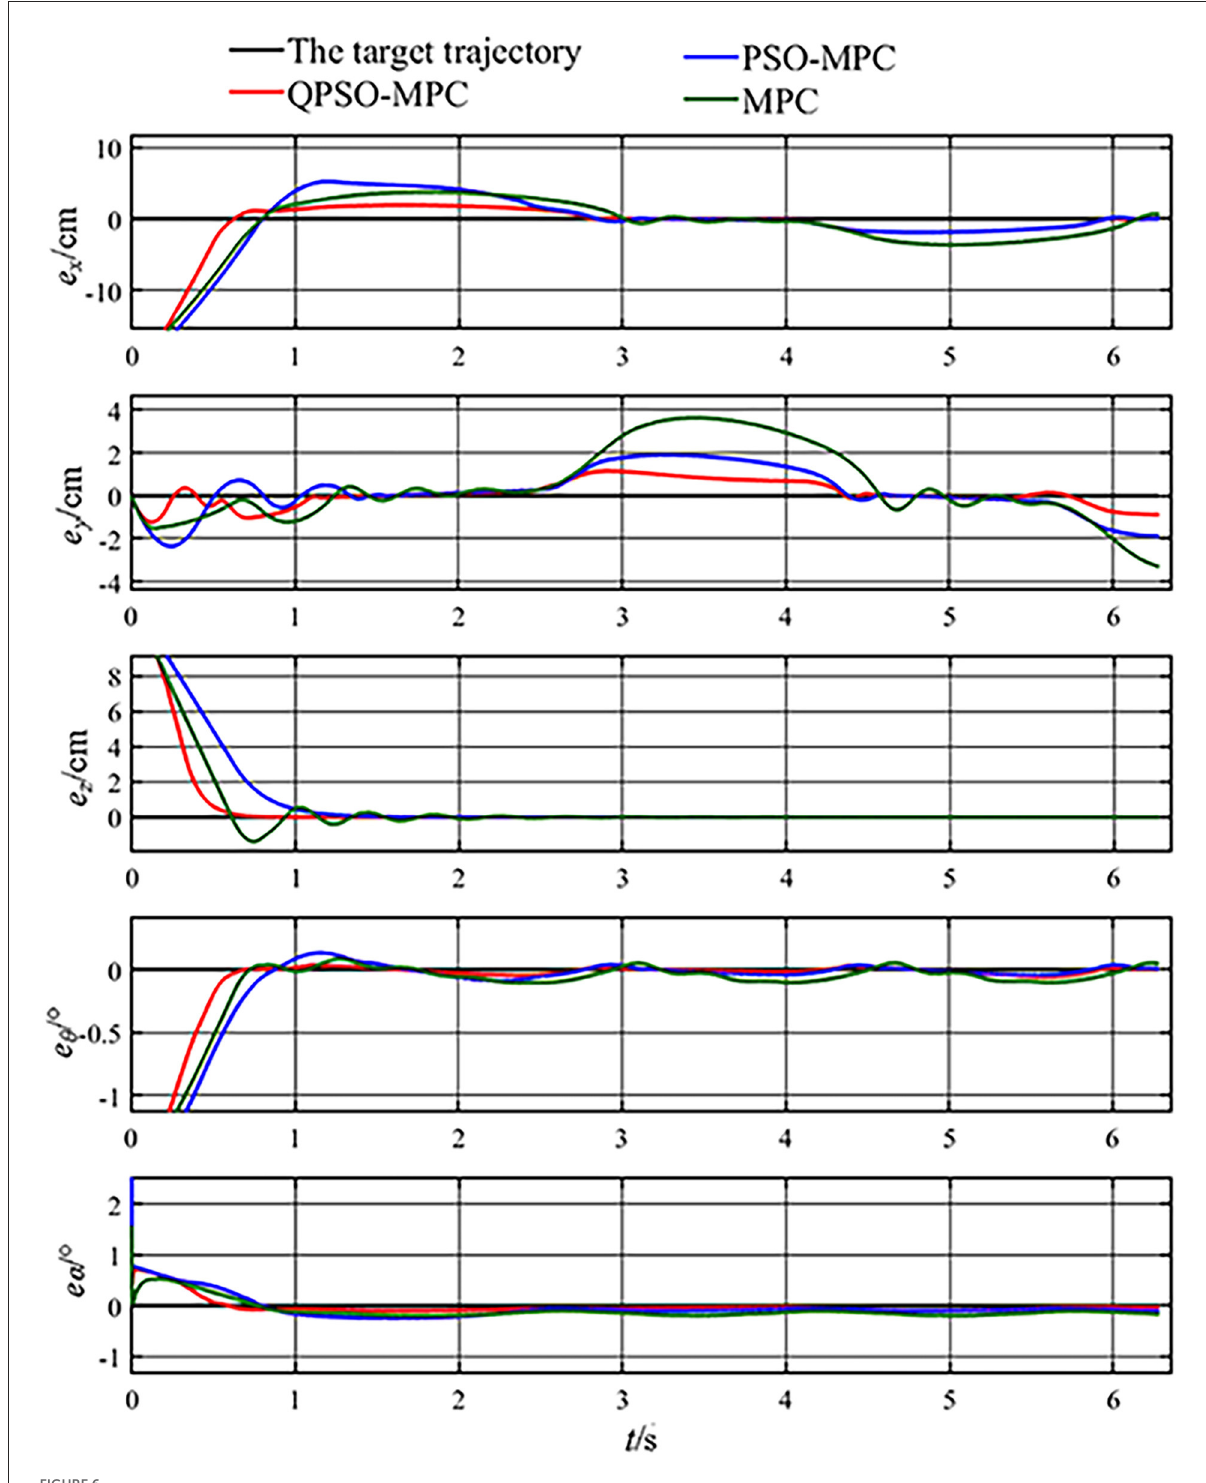
FIGURE6 Tracking errors of circular trajectory